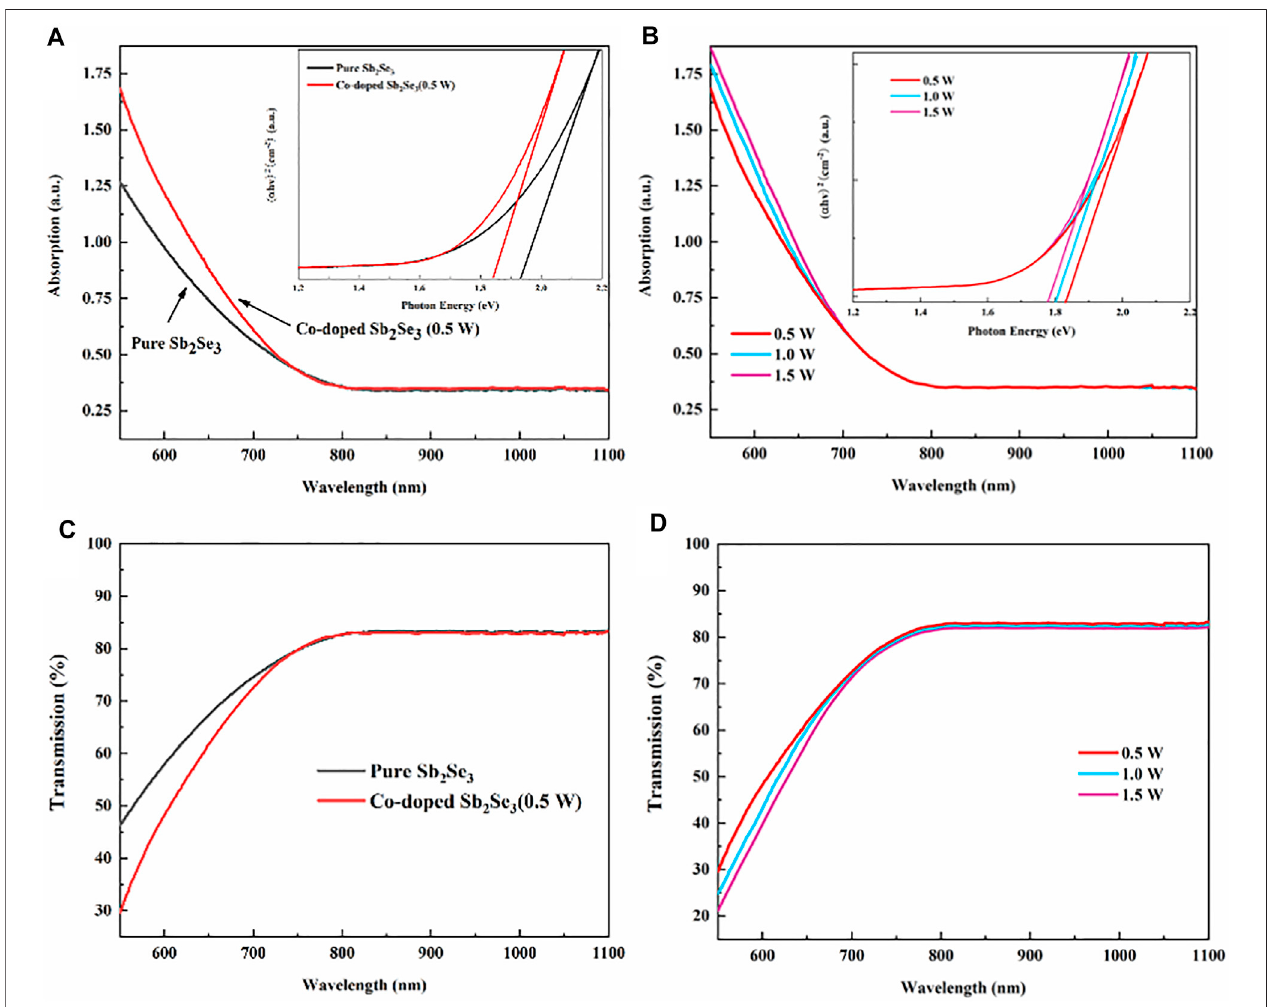
FIGURE 5 | (A, B) The linear absorption spectrum of pure and Co-doped Sb 2 Se 3 nano fi lms. The inset shows the relationship between the incident photon energy and absorbance. (C) and (D) exhibit the transmittance spectrum of pure and Co-doped Sb 2 Se 3 nano fi